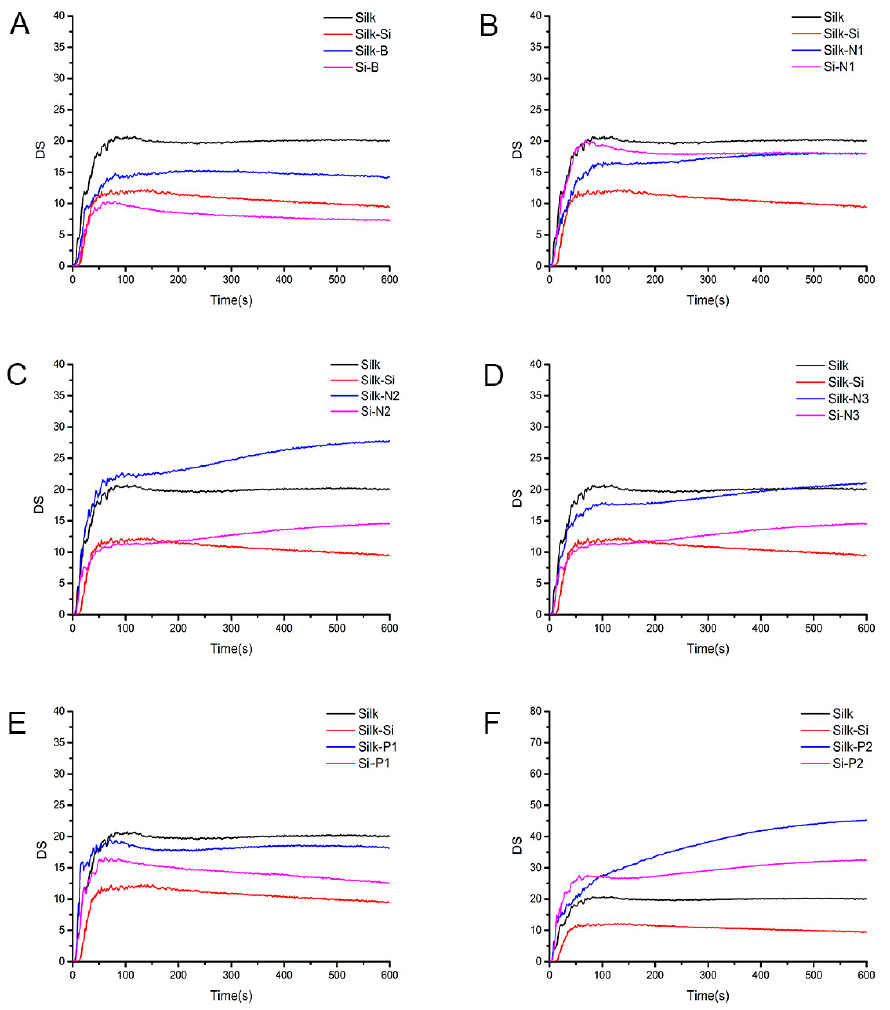
Figure 11. The smoke density curve of all samples. Silk, Silk-Si, Silk-B, Si-B ( A ); Silk, Silk-Si, Silk-N1, Si-N1 ( B ); Silk, Silk-Si, Silk-N2, Si-N2 ( C ); Silk, Silk-Si, Silk-N3, Si-N3 ( D ); Silk, Silk-Si, Silk-P1, Si-P1 ( E ); Silk, Silk-Si, Silk-P2, Si-P2 ( F ). Compared with the original fabric (Silk), the smoke density of the finished silk (Silk-B,